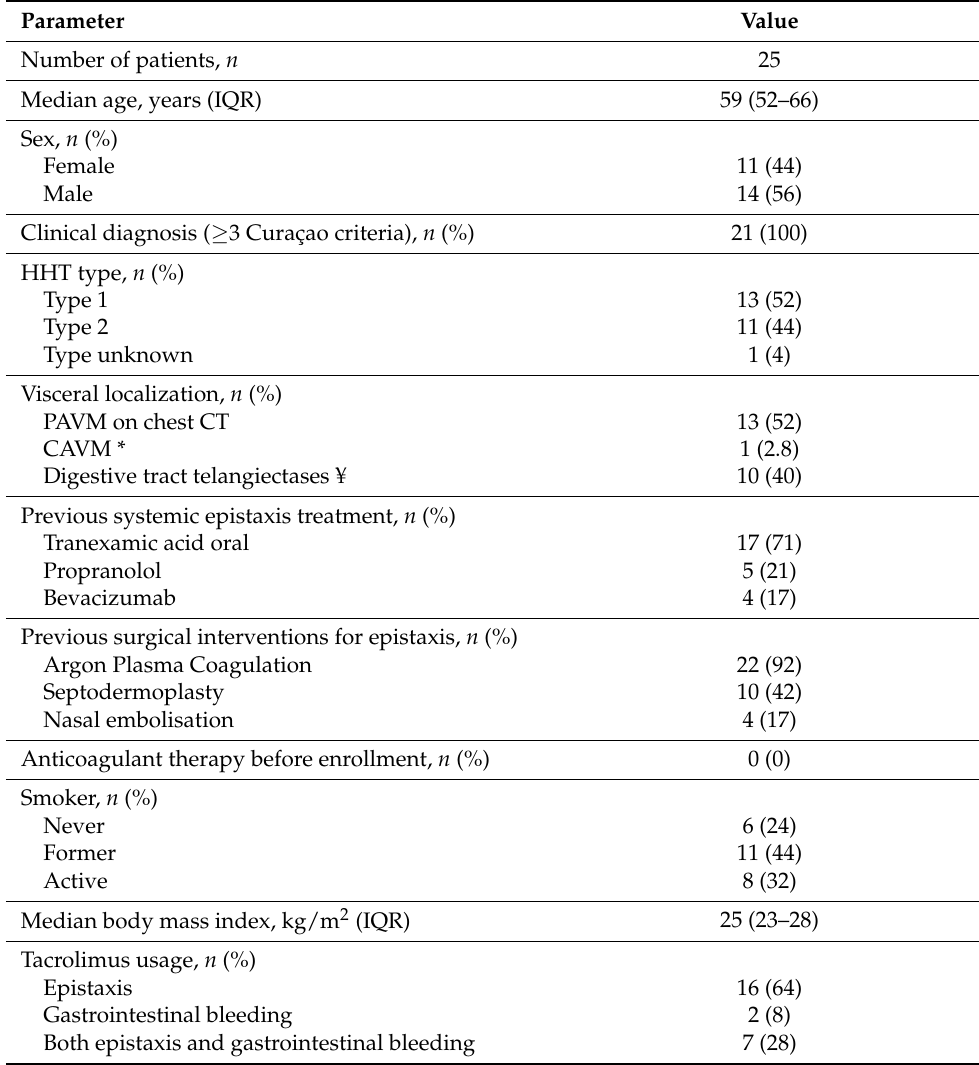
Table 1. Baseline